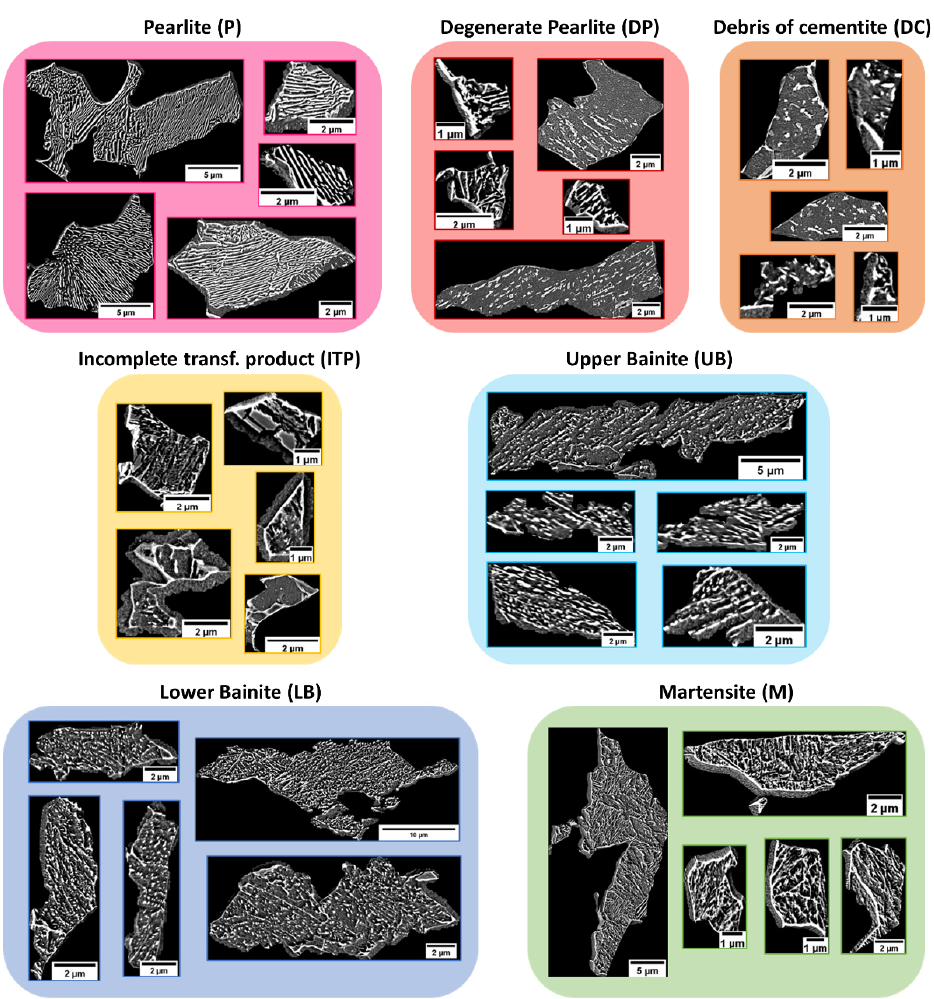
Figure 3. Seven microstructure classes considered for classification.